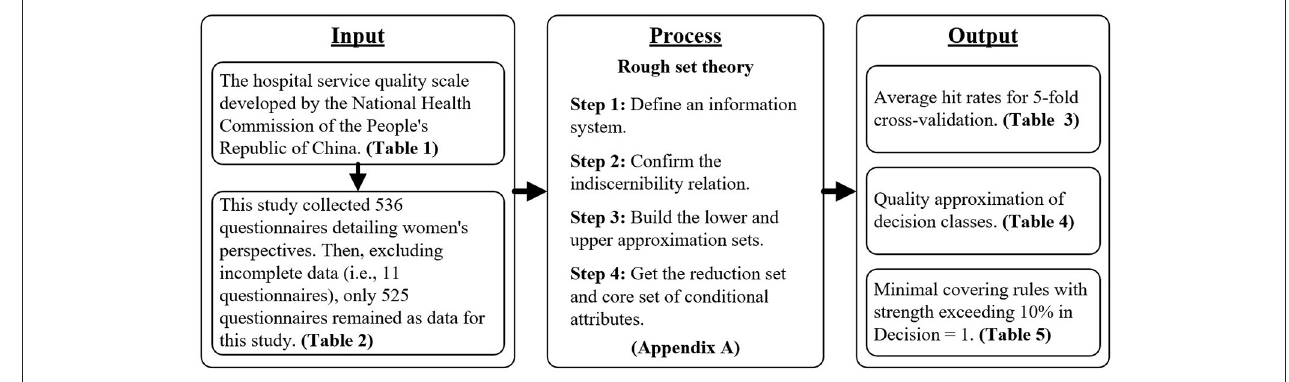
FIGURE 1 | The research flow chart.